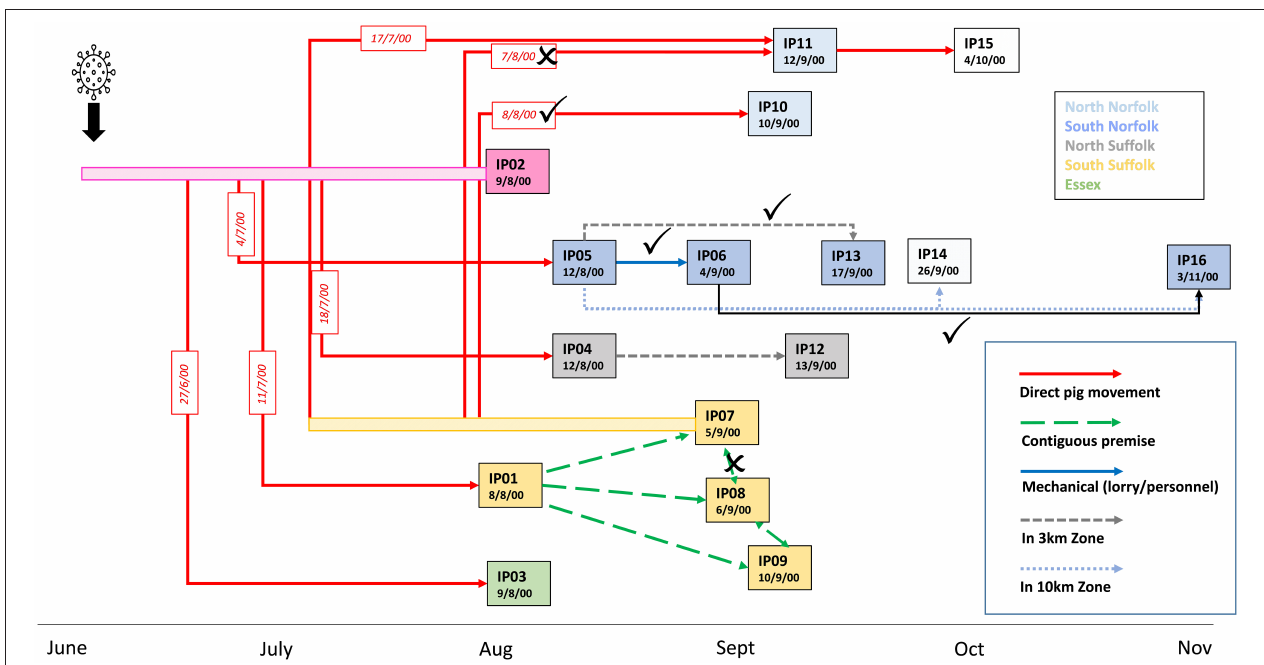
FIGURE 3 | Updated model of the linkages between the affected pig holdings in the UK CSF outbreak in 2000. Transmission links identified by epidemiological investigations that are corroborated by phylogenetic analysis are indicated with ticks and links that are not supported by crosses. A new transmission route implicated by the phylogenetic analysis is indicated by the black